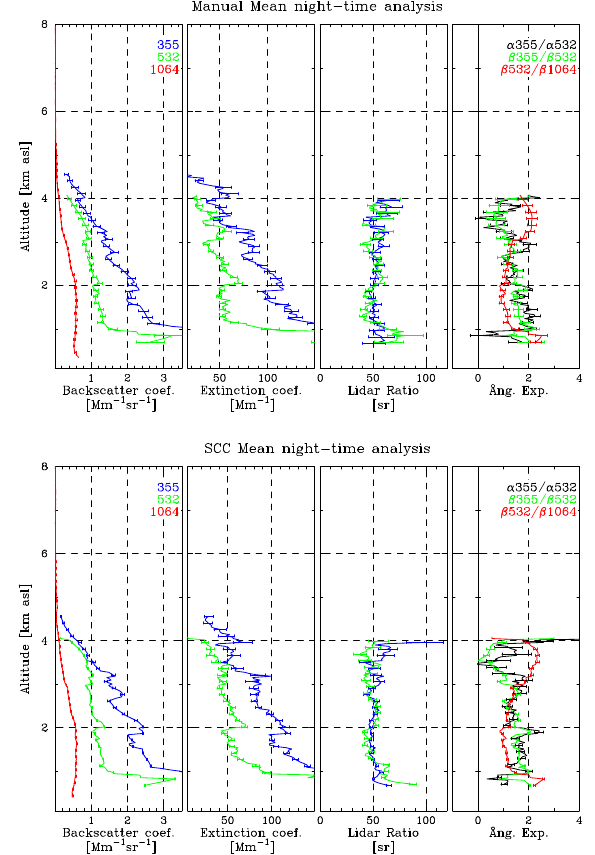
Figure 12. Mean night-time analysis comparison for the Leipzig station (Polly XT system). In the upper graph the mean profiles ob- tained using the manual analysis are shown, while in the bottom graph the results obtained by the SCC are presented. Several mea- surement cases (see Table 2) have been analysed, and the corre- sponding backscatter and extinction profiles have been averaged (left two panels of each graph). The other two panels of each graph show the lidar ratios and the Ångström exponents, respectively as calculated from the mean aerosol extinction and backscatter pro-